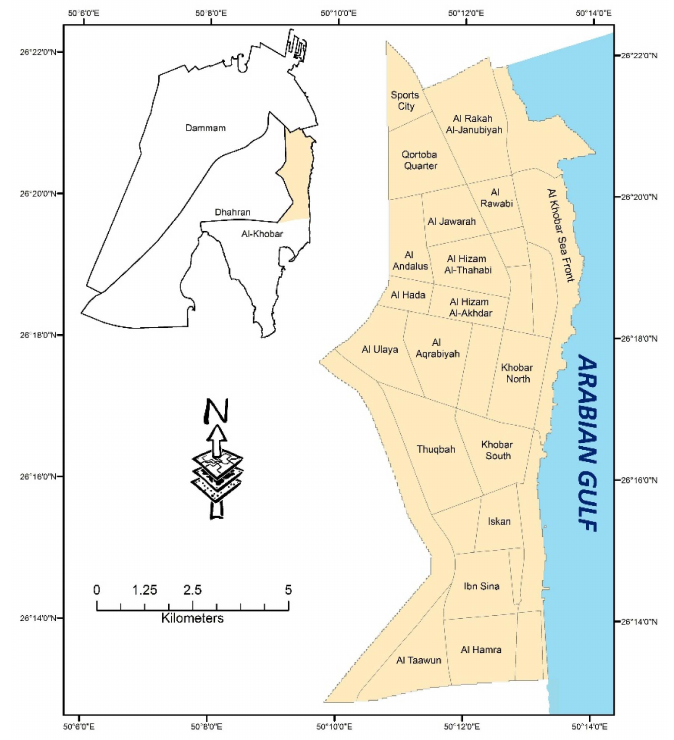
Figure 1. The study area with the major districts within the city of